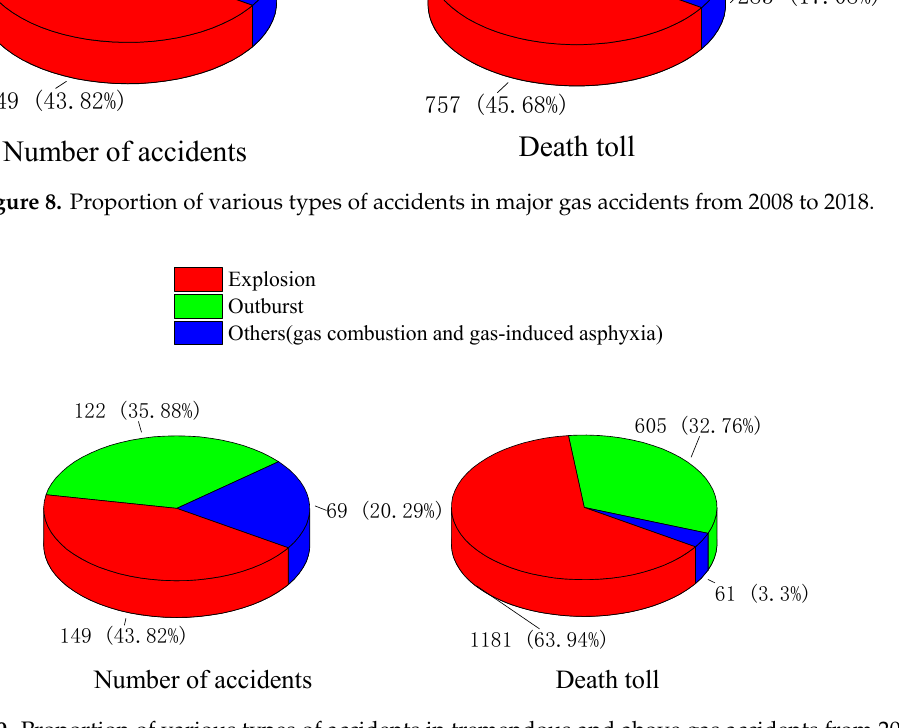
Figure 9. Proportion of various types of accidents in tremendous and above gas accidents from 2008 to 2018.